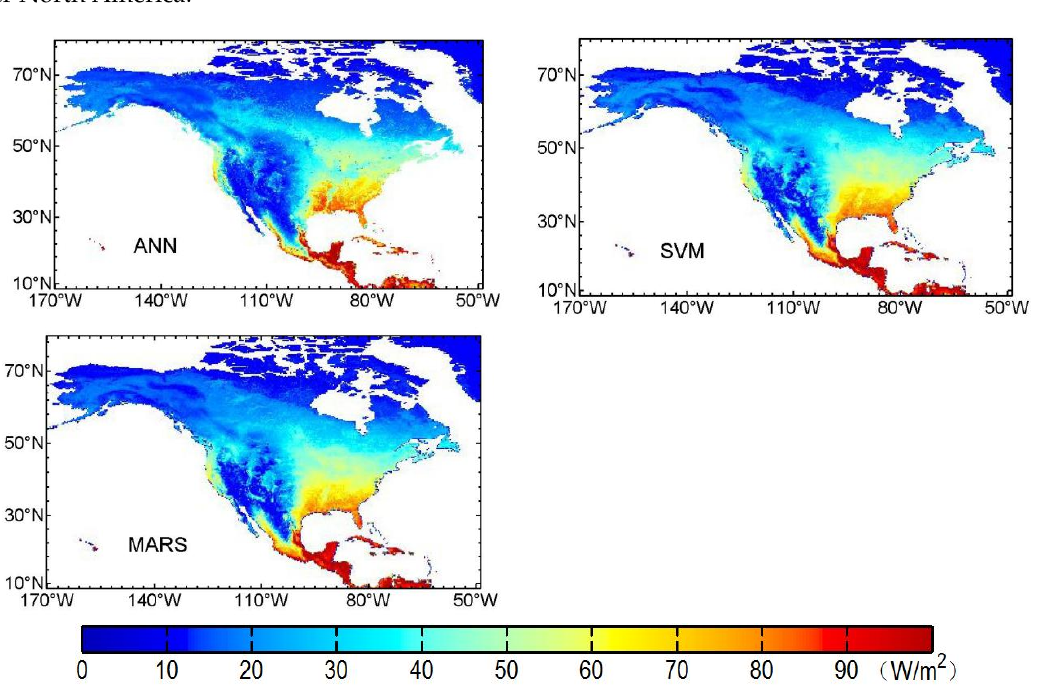
Figure 8. The map of mean annual terrestrial LE from 2002 to 2004 at a spatial resolution of 0.05° using three machine learning algorithms driven by MERRA meteorology over North America.